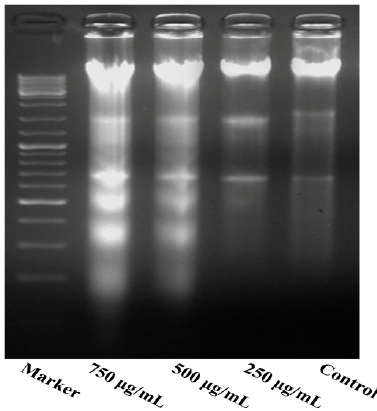
Figure 5. DNA fragmentation of MG63 cells. DNA of cells treated with serial concentrations of PZH (250, 500 and 750 μ g/mL) for 24 h were analysed.